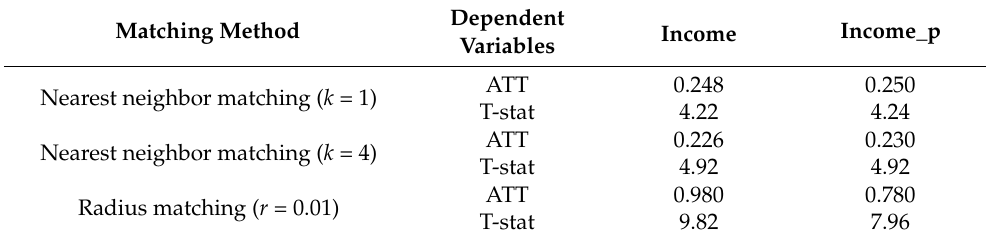
Table 6. The impact of mobile payment on household income: the Propensity Score Matching